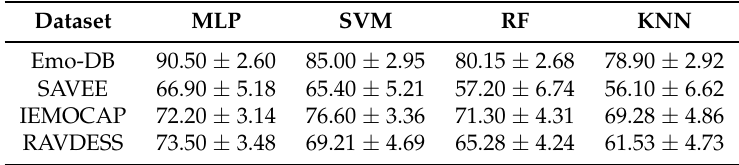
Table 4. Weighted average recall and standard deviation of speaker-independent SER experiments with feature selection.